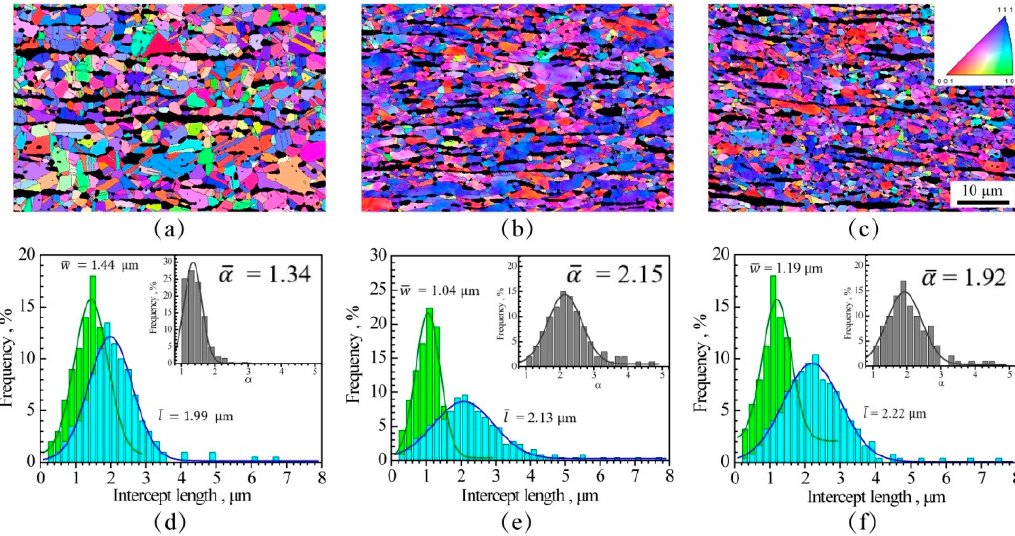
Figure 7. EBSD images and grain morphologies of γ -austenite phase for ( a ) untested sample; ( b ) sample after testing at strain rate of 0.0006/s; ( c ) sample after testing at strain rate of 56/s. The EBSD images correspond to the true uniform tensile strains of 28.1% (Figure 7a) and 20.9% (Figure 7b). Histograms showing the statistics of the grain size distribution and aspect ratio measurements for: ( d ) untested sample; ( e ) sample after testing at strain rate of 0.0006/s; ( f ) sample after testing at strain rate of 56/s. Table 1. Summary of data for strain partitioning between two phases at two different strain rates. Strain Rates